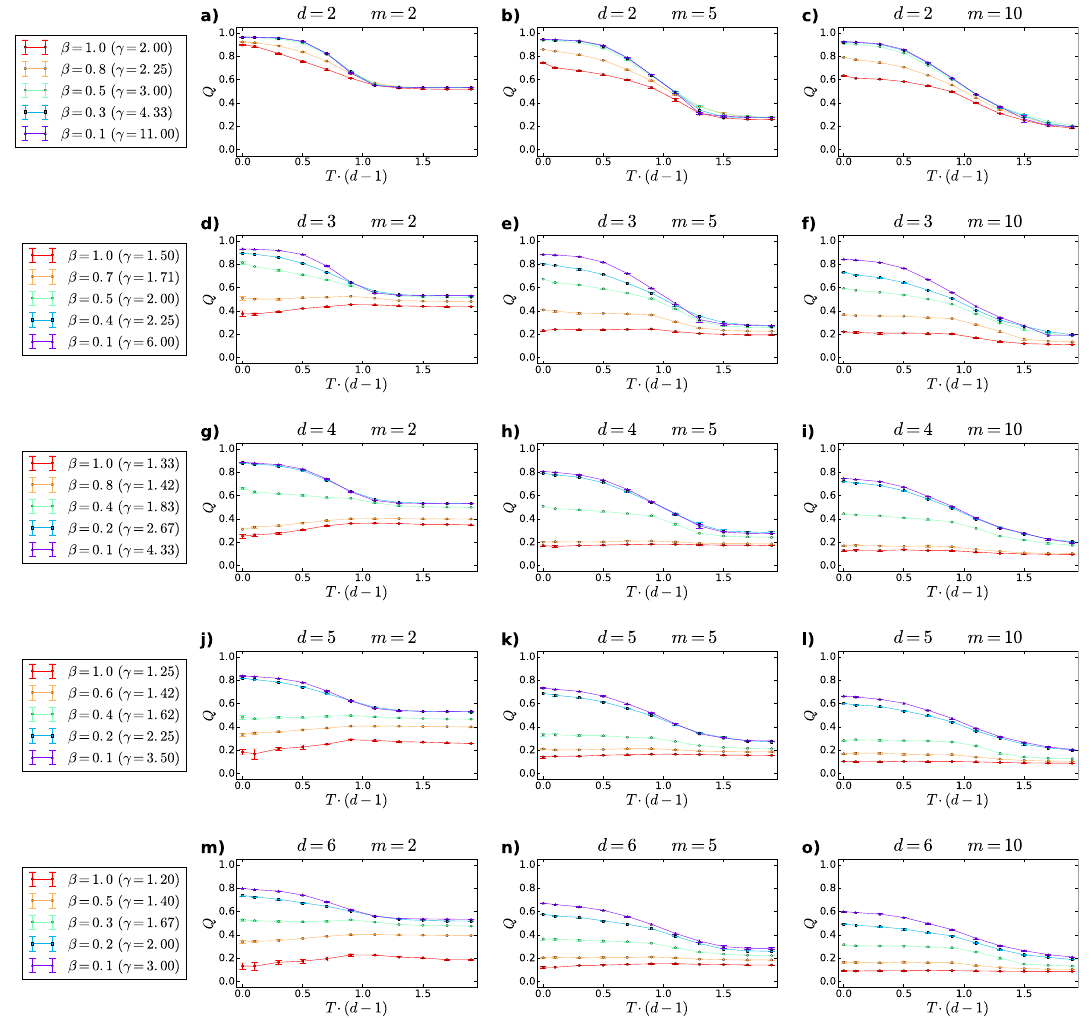
Figure 5. The highest modularity Q achieved among the communities obtained by the asynchronous label propagation, the Louvain and the Infomap algorithms in d PSO networks, as a function of the rescaled 1 ) . The dimension d is constant across the panel rows (i.e., in panels a – c , d – f , g – i , j – l ( d temperature T · − and m – o ), whereas the expected average degree 2 m is constant across the panel columns, as indicated by the panel titles. The different curves in a given subplot correspond to different values of the popularity fading parameter β (yielding different degree decay exponents γ ), listed for each dimension in the leftmost panel of the corresponding row. The displayed data points were obtained by averaging over 5 d PSO networks of N 1 , the error bars indicate the standard ζ 2 nodes at curvature K = − = −